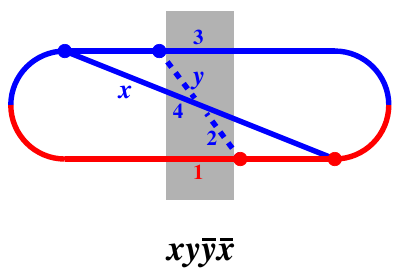
Figure 11 . The canonical “crossed” diagram. Particles in the (shaded) region of 4-particle evolu- tion are numbered according to the convention of ref.